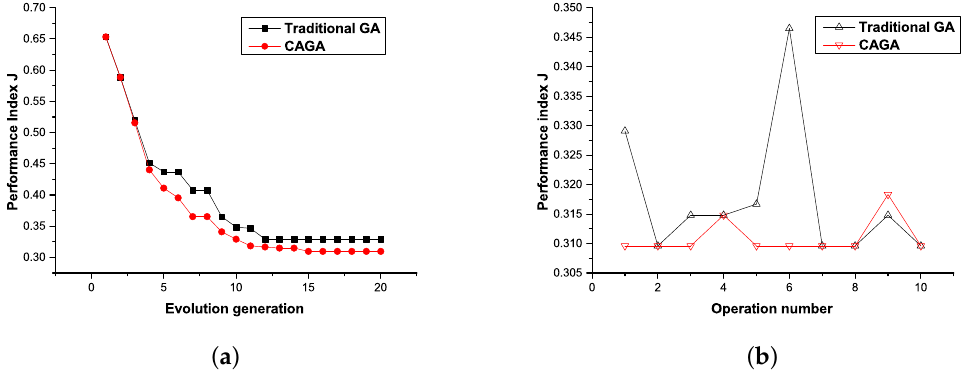
Figure 14. Algorithm performance comparison, ω 1 = 0.4, ω 2 = 0.3, ω 3 = 0.3. ( a ) Convergence comparison; ( b ) Robustness